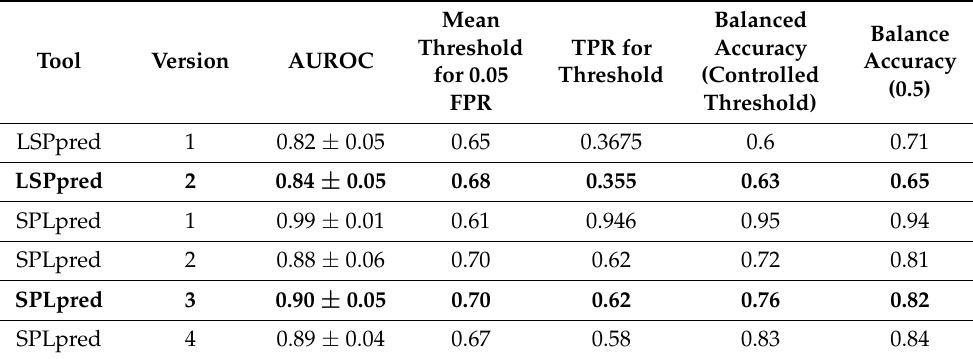
Table 2. Tool results. Accuracy statistics for each version of LSPpred and SPLpred considered. Preferred models in